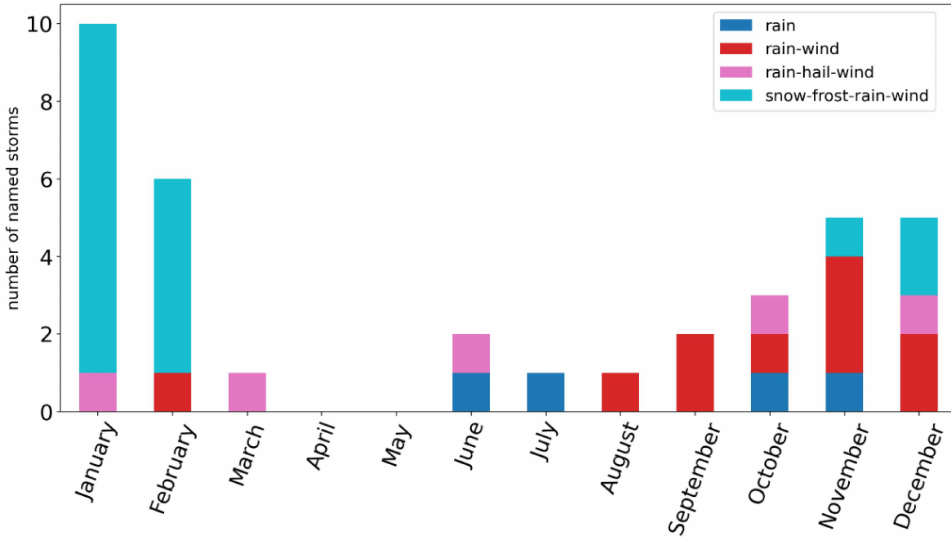
Figure 2. Number of named storms in Greece per month between January 2017 and September 2021. Color bars denote the main hazards associated with each